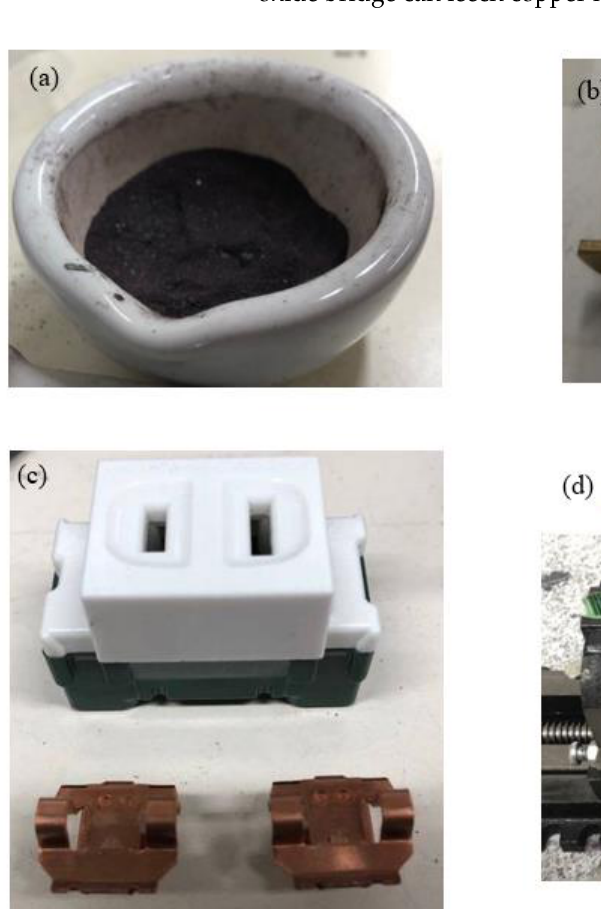
Figure 2. Pictures of the experimental apparatuses. ( a ) The copper oxide powder used to accelerate the growth of the oxide bridge. ( b ) A brass electrical plug that is typical of what is used in Japan for DIY repair and replacements. ( c ) A typical electrical socket used in Japan. The objects at the bottom of the image are the interior copper contacts from the socket. ( d ) The clamping apparatus used to move the plug and blade and to hold them firmly while data was recorded.